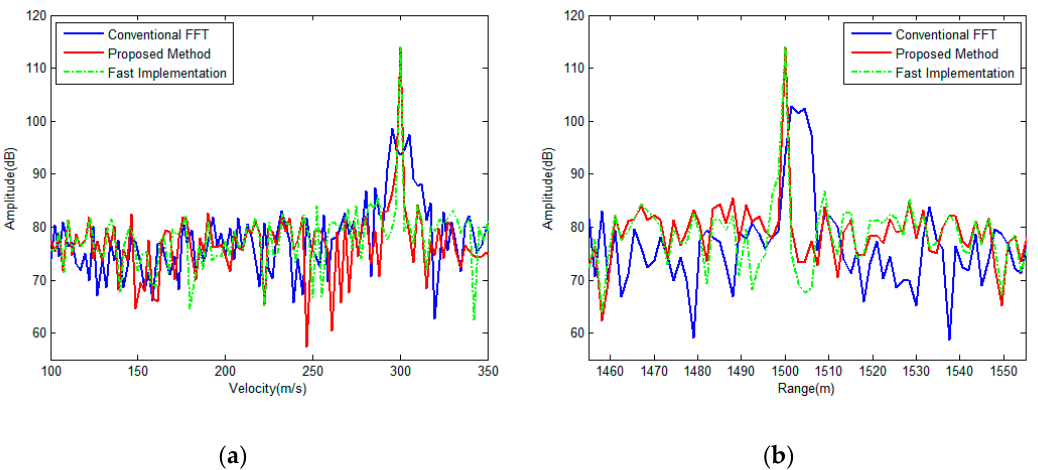
Figure 5. Comparison of the integration results. ( a ) Comparison of Doppler profiles; ( b ) comparison of range profiles.